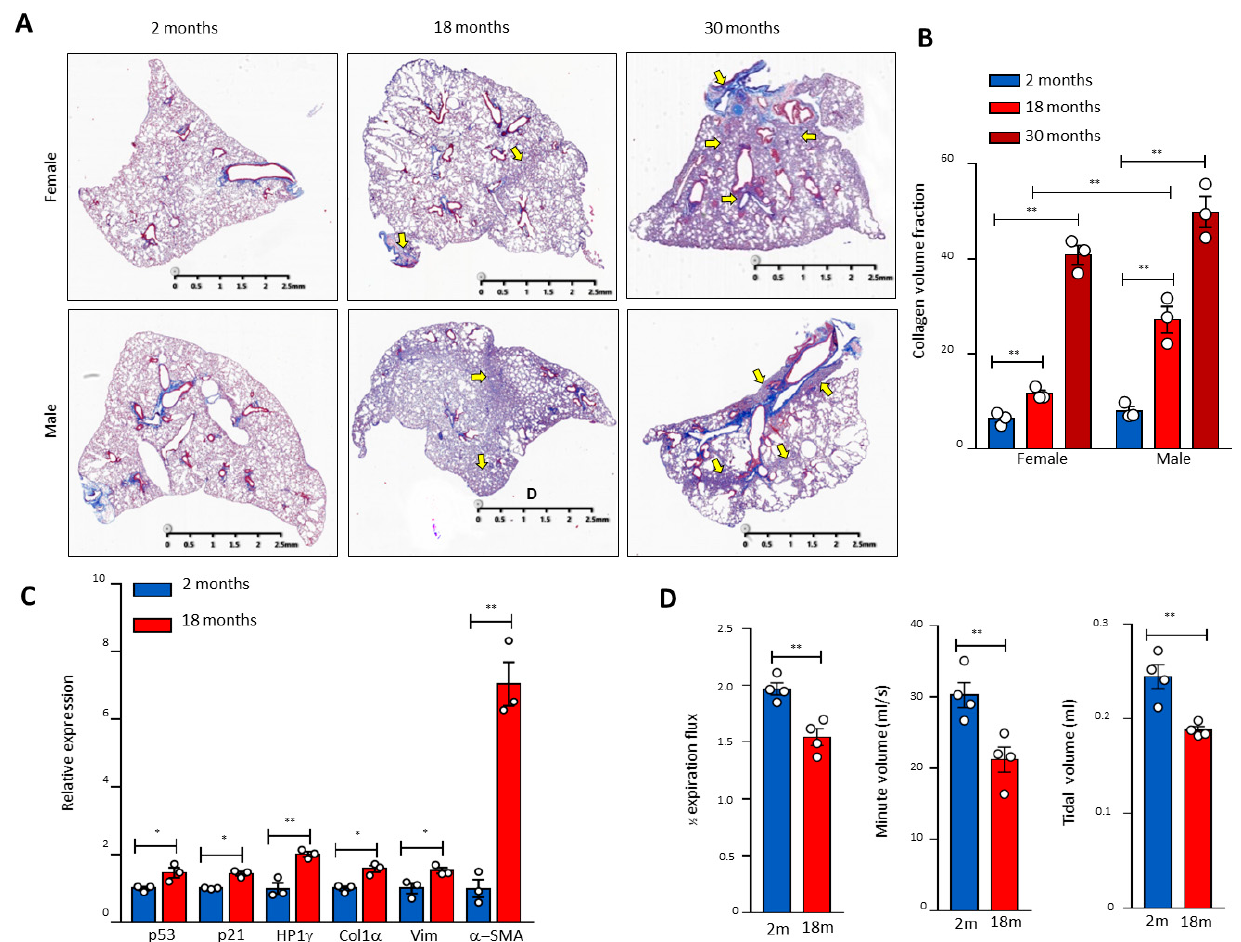
Figure 1. Age-related pulmonary fibrosis in mice with compromised lung respiratory function and activation of the p53 pathway. ( A ) Masson’s staining of mouse pulmonary sections of different genders and ages. Arrows indicate pulmonary fibrosis. ( B ) Quantitation of the pulmonary fibrosis by ImageJ. Three mice per group. ( C ) RNA was extracted from 2- and 18-month-old lung tissues, and the gene expression of p21, p53, HP1 γ , collagen (Col1 α ), Vimentin (Vim), and α -SMA was determined by real-time PCR and graphed as fold-activation value based on three mice in each group. ( D ) The mouse respiratory functional analysis of different ages. The 1/2 expiration flux, tidal volume, and minute volume were determined by the eSpira Forced Manoeuvers System. Four mice per group. * and ** indicate statistical significance p < 0.05 and p < 0.01 respectively.